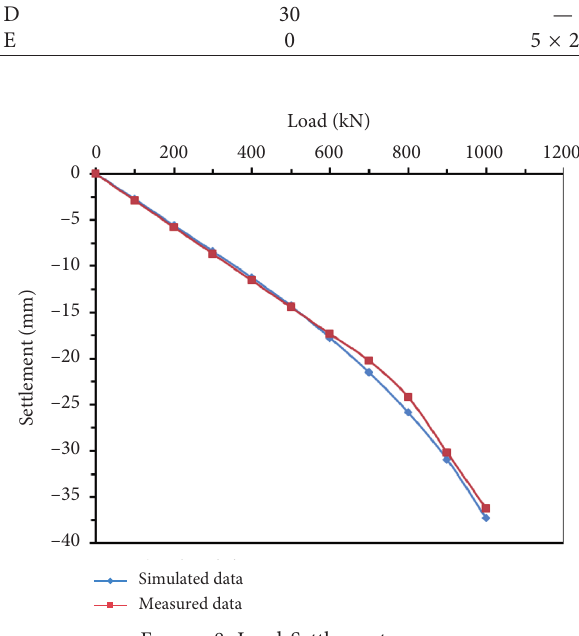
Figure 8: Load-Settlement